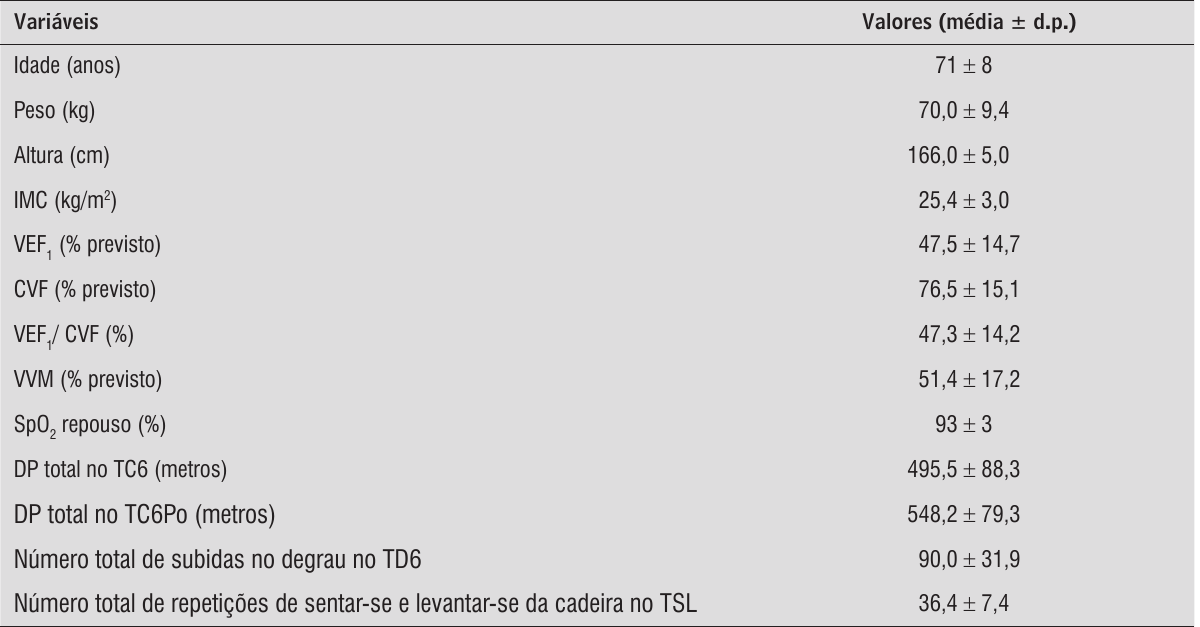
no repouso, distância percorrida nos TC6 e TC6Po, 2